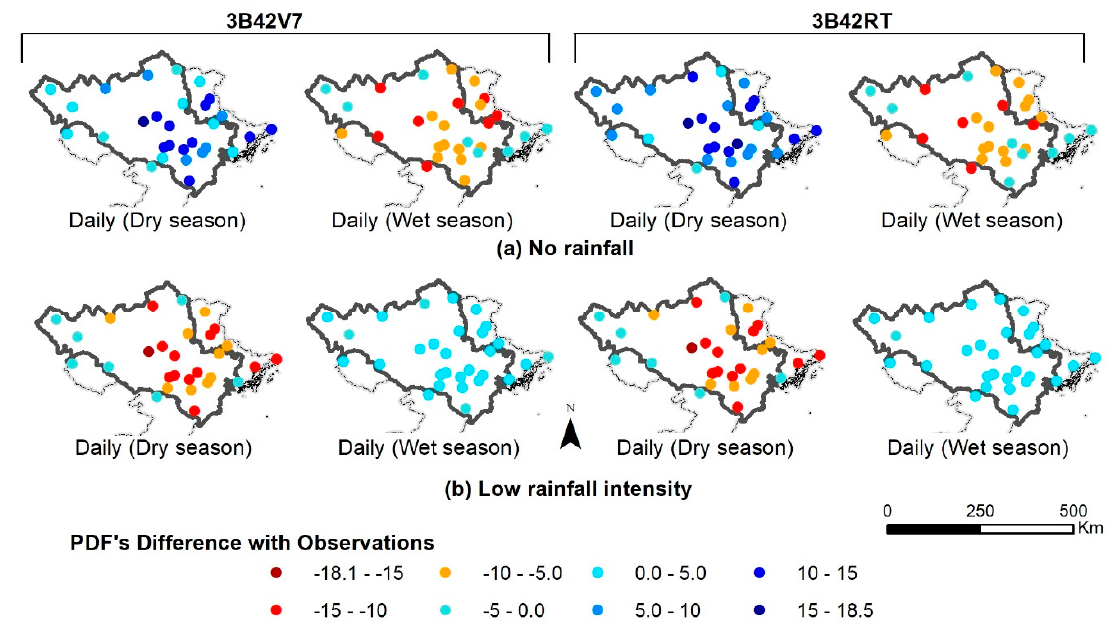
Figure 8. Percentage difference of PDF between TMPA 3B42V7, TMPA 3B42RT, and observation at ( a ) no rainfall intensity (0–0.6 mm/day) and ( b ) low rainfall intensity (0.6–6 mm/day) over the Red–Thai Binh River Basin from March 2000 to December 2016.